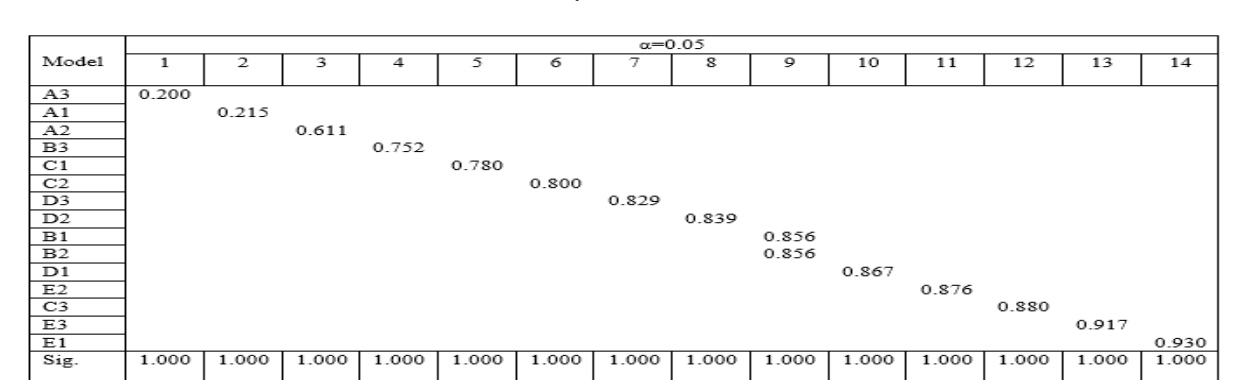
Figure 2. Tukey’s HSD test for G-mean.